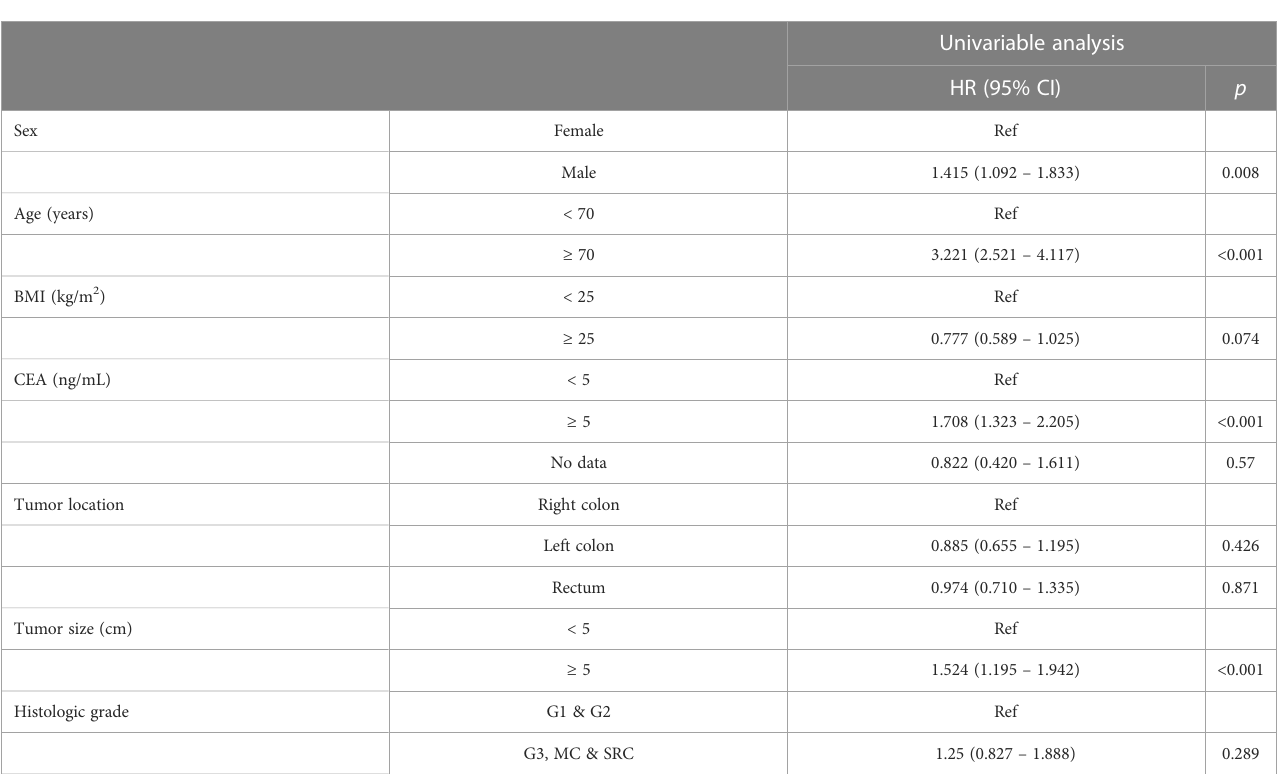
TABLE 2 Univariable analysis associated with the overall survival